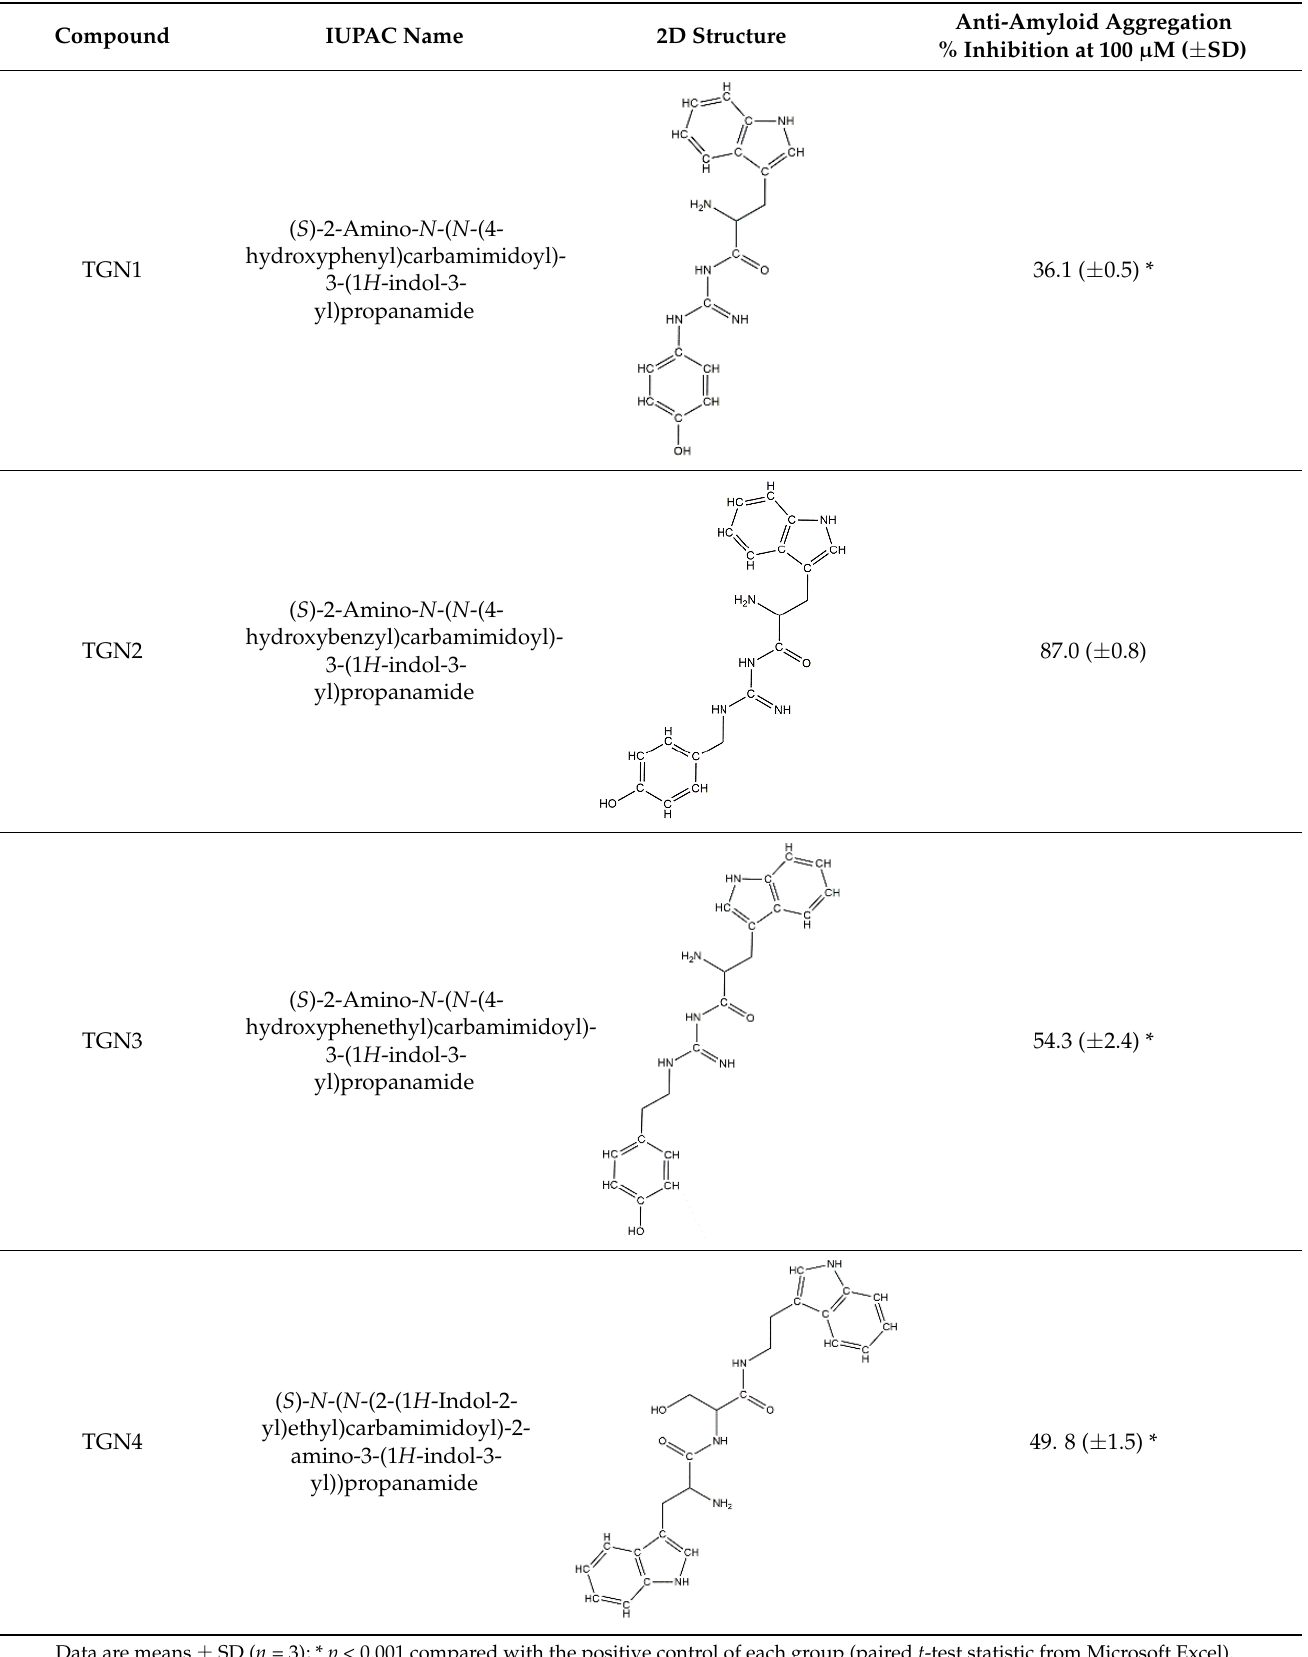
Table 1. The structure and the activity of the TGN series of compounds [6].